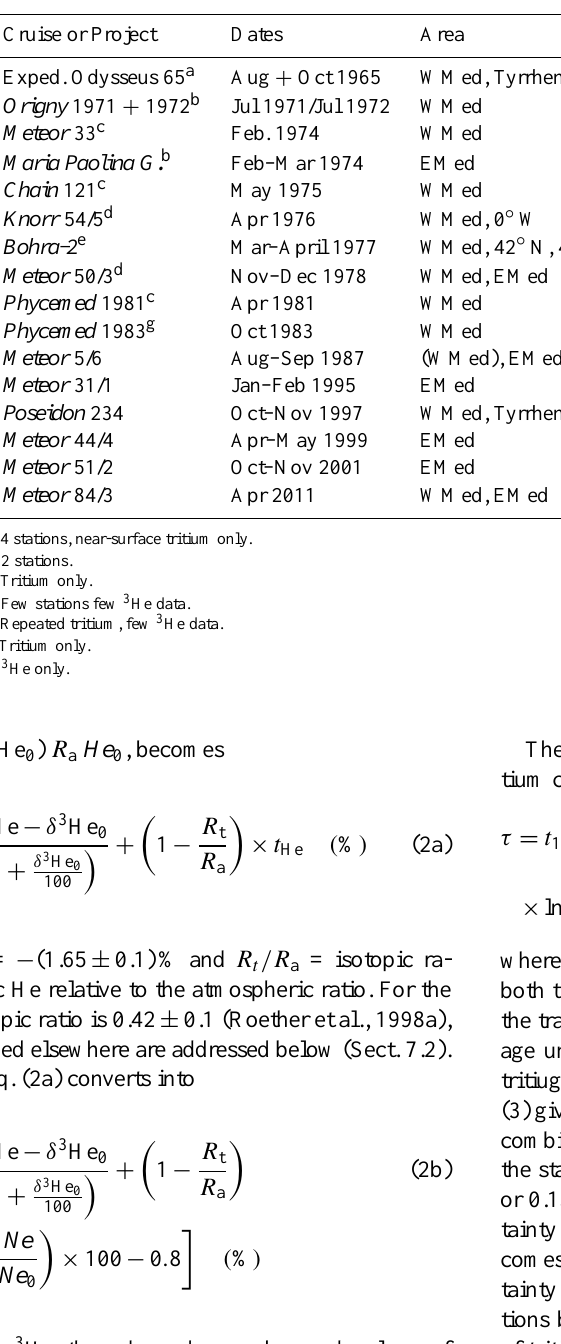
Table 1. Cruises contributing tritium and He isotope data for the present